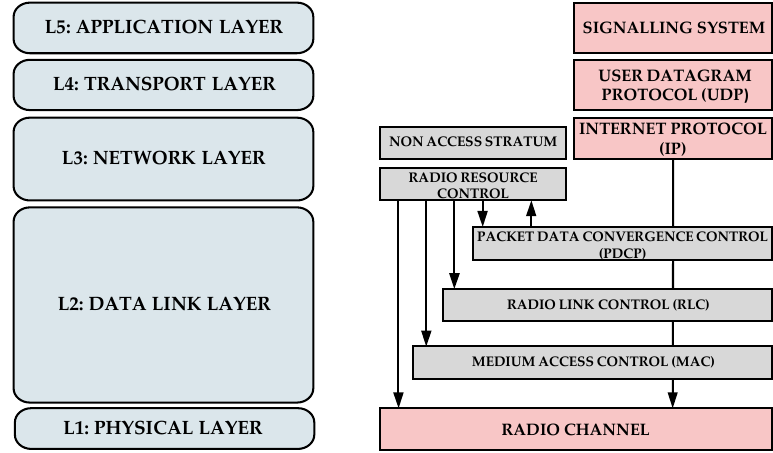
Figure 1. Protocol stack design and testing